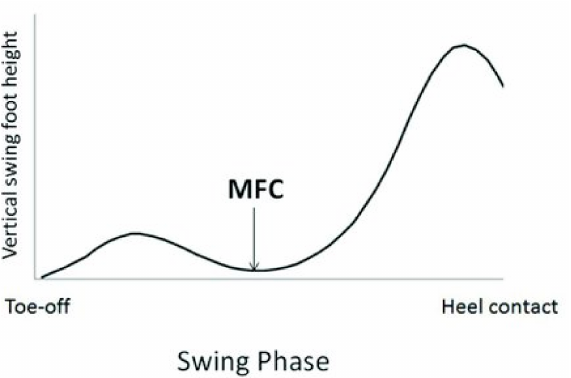
Figure 1. Vertical displacement of a point on the swing foot near the great toe over one stride. The minimum foot clearance (MFC) is defined by the local minima of the swing foot following toe-off. (Figure by Nagano et al. [6] licensed under CC by